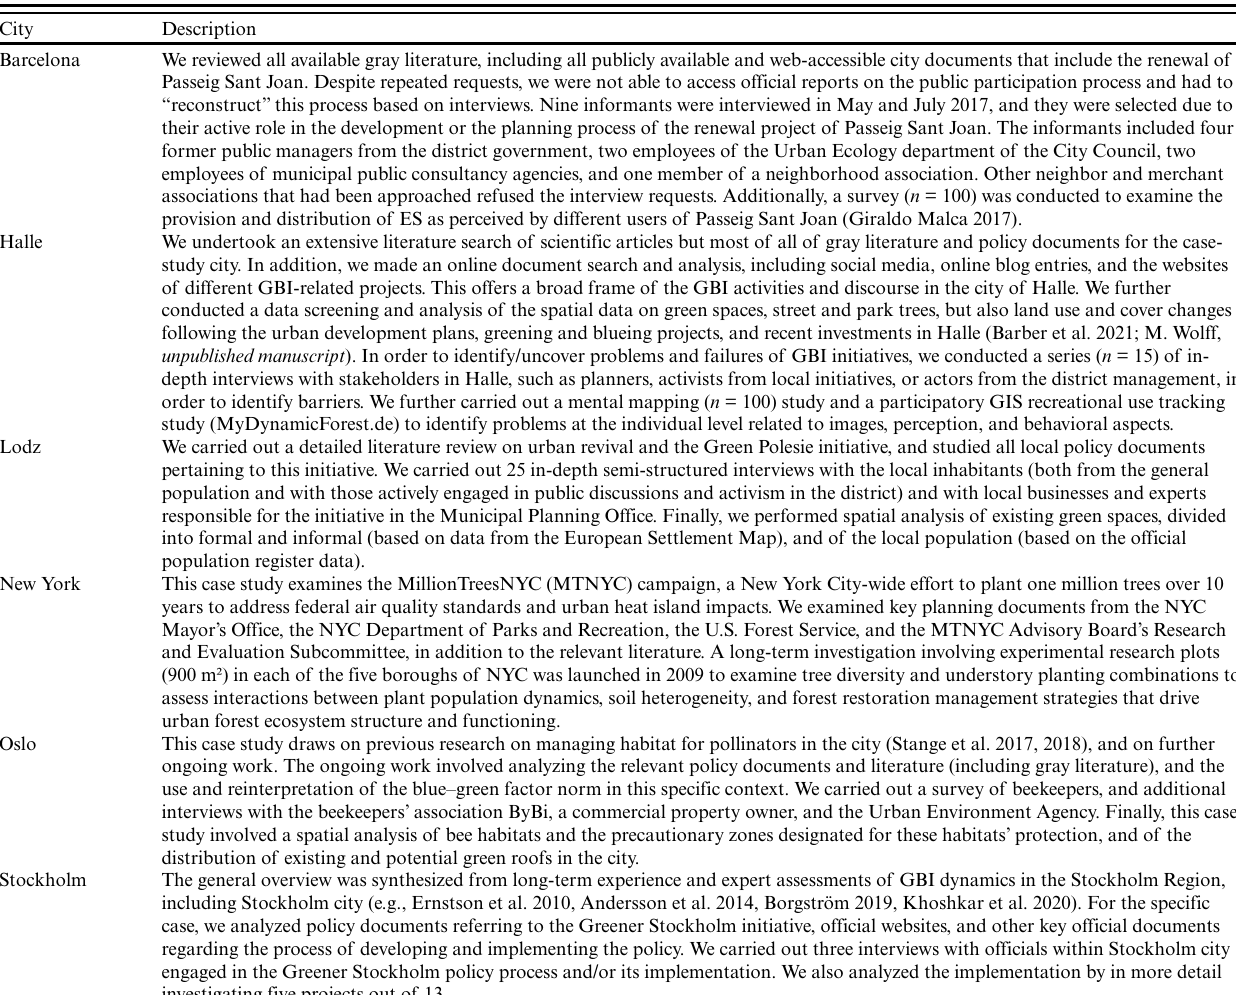
Table 3. Methods and data sources specific to each case